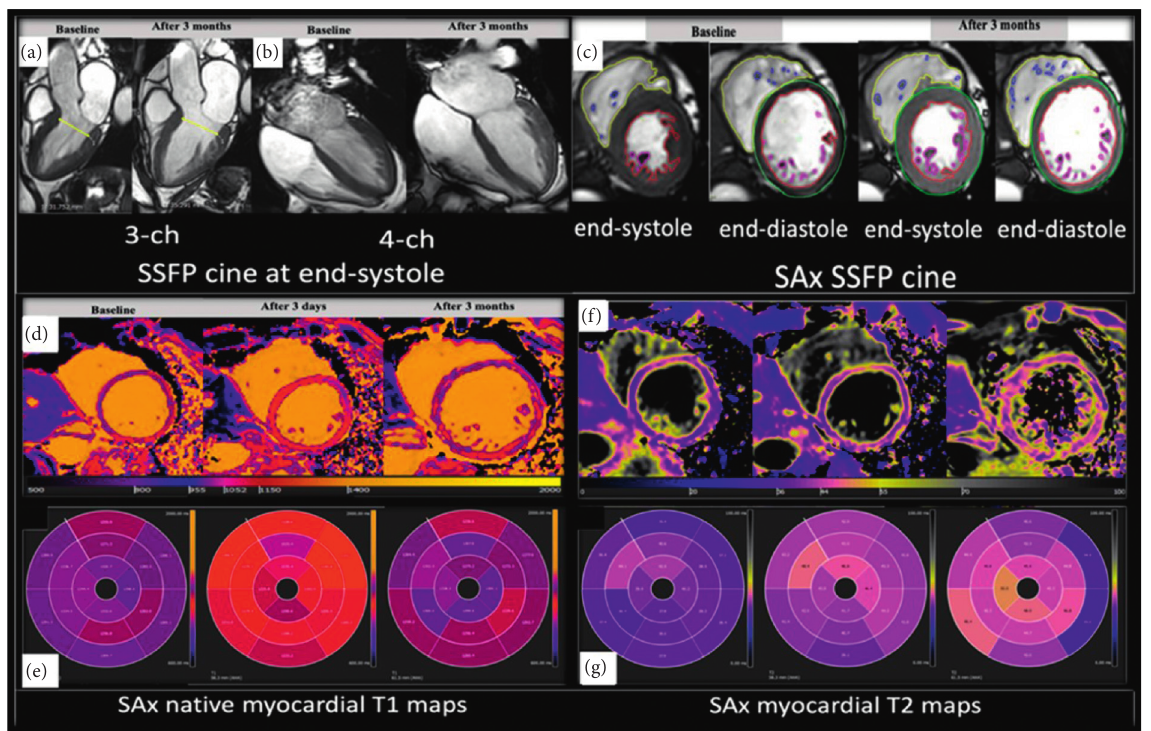
Figure 1: Representative images of trastuzumab-induced cardiotoxicity. Cine 3-chamber (a) and 4-chamber views (b) as well as short axis view (c) during baseline study (LVEF � 66%) and 3 months thereafter (LVEF � 54%). Native T1 (d) shows reduction of global left ventricular value after 3 days (baseline � 1196ms, 1st follow-up � 1172ms, and 2nd follow-up � 1277ms). Myocardial T2 (f) shows subtle elevation of global value after 3 months (baseline � 40 ms, 1st follow-up � 43ms, and 2nd follow-up � 44ms). The average segmental T1 and T2 times are displayed as “bull’s eye” images (e, g). The colour maps represent continuous T1 and T2 values. LVEF, left ventricular ejection fraction; reproduced with permission from Abdelmonem Atia et al. [22]. Table 1: Advantages and disadvantages of imaging